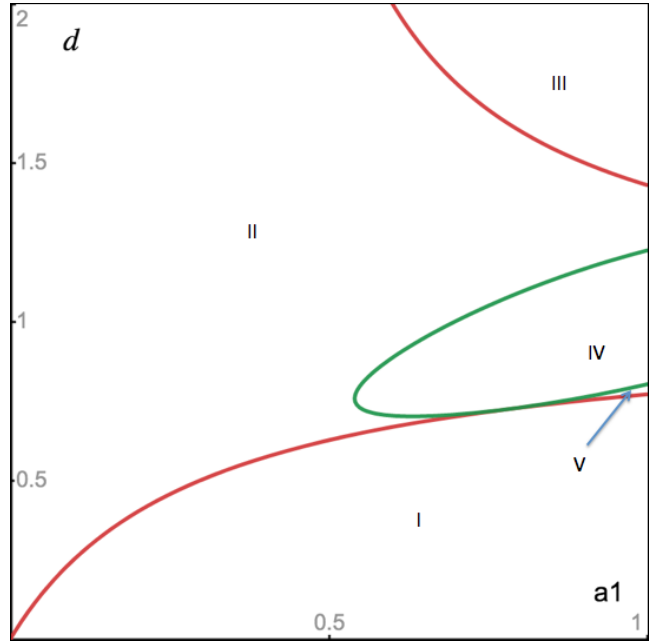
Figure 2. Stability map around the tumour-free equilibrium point, E 0 when τ > 0.